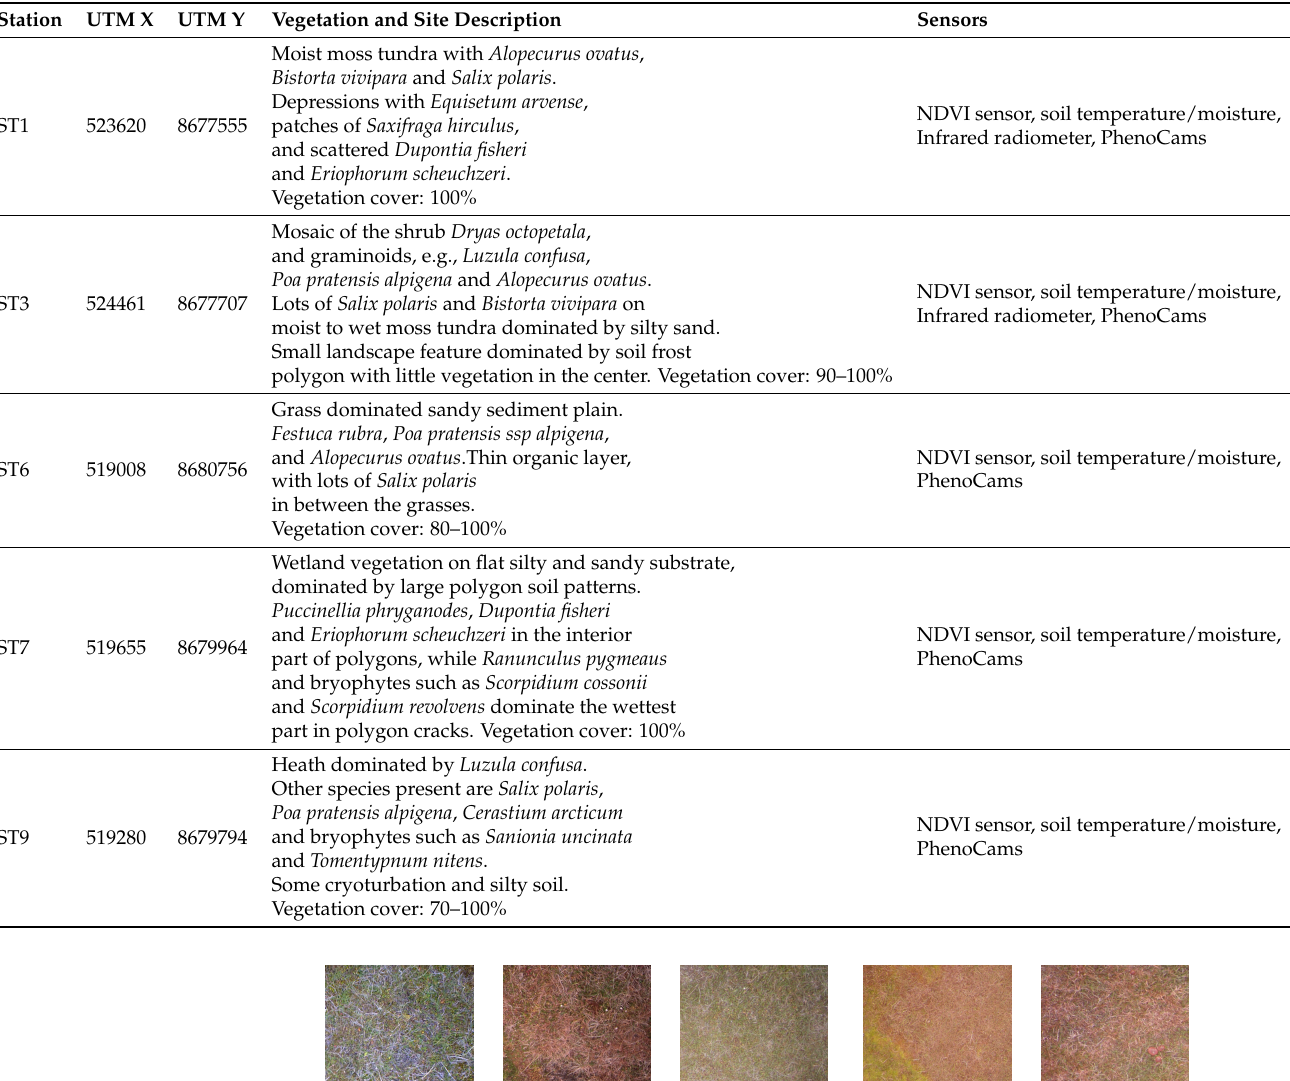
Table 1. Description of ground stations location (UTM zone 33 north, datum WGS84), equipment and vegetation in Adventdalen during season 2017 and 2018.